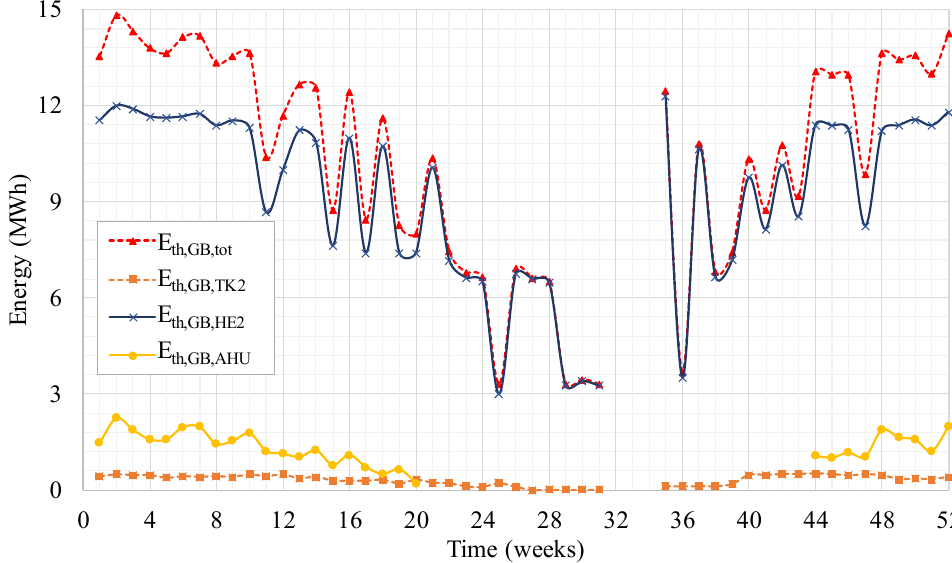
Figure 10. Thermal energy of the boiler system and thermal energy supplied by the boiler system to DHW tank, swimming pool heat exchanger and air handling unit—evacuated tube collectors, weekly analysis.